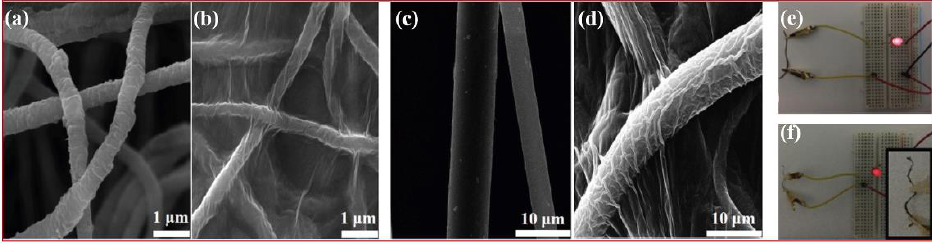
Figure 6. SEM images of ( a ) silk fibroin, ( b ) rGO-coated silk fibroin, ( c ) spider web, and ( d ) rGO- coated spider web. The electrical conductor of ( e ) rGO-silk yarn and ( f ) rGO-spider web. Reprinted with permission from Reference [44]. Copyright (2017) John Wiley and Sons.